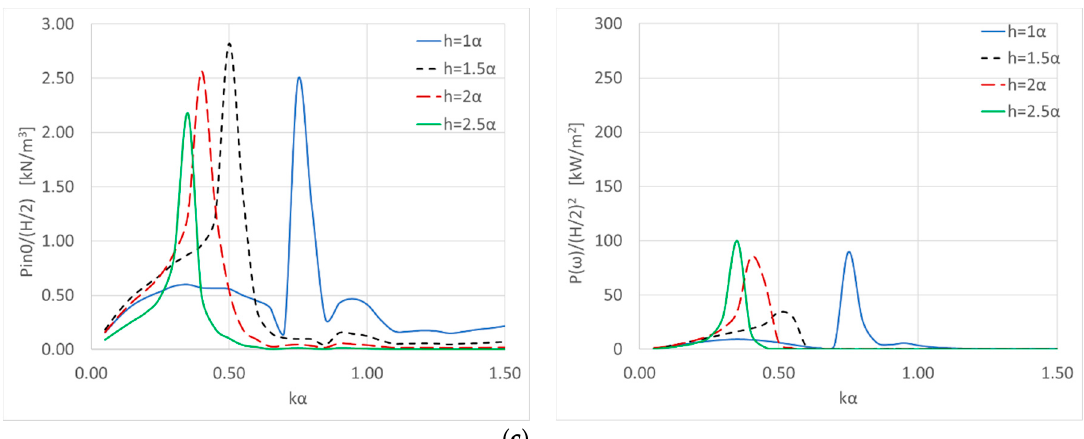
Figure 8. Air pressure inside the 1st OWC (left column figures) and array’s absorbed power P( ω ) (right column figures) versus k α for various examined OWC draughts and wave heading angles: ( a ) β = 0; ( b ) β = π /6; ( c ) β = π /4.